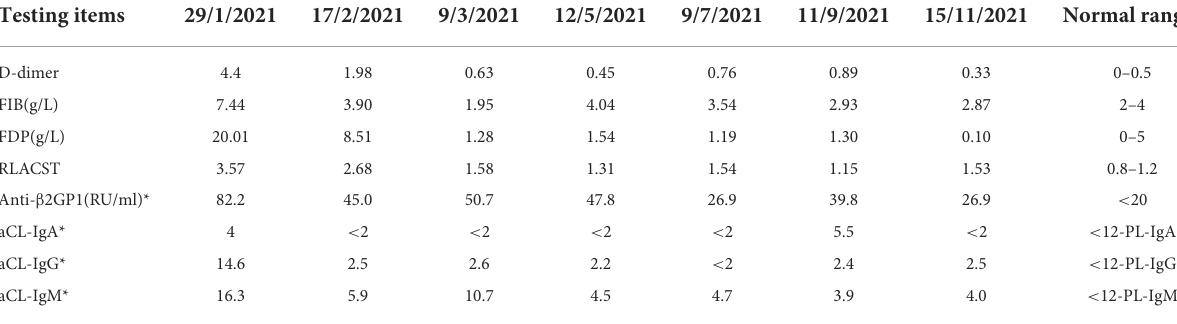
TABLE 1 Coagulation function and aPL antibodies in the patient during following up. Testing